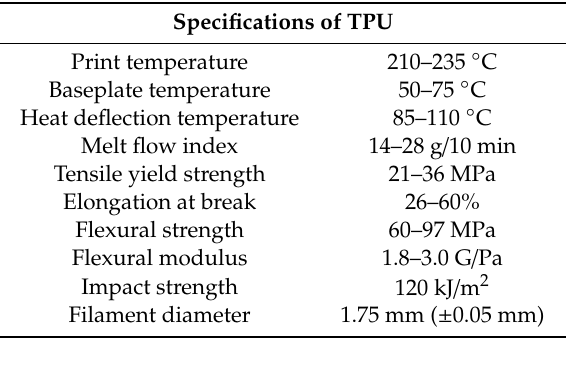
Table 2. Product specifications of thermoplastic polyurethane (TPU).